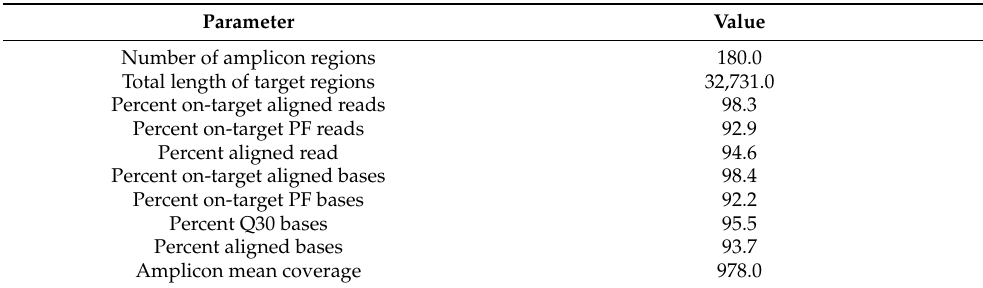
Table 1. Sequencing Parameters. General sequencing metrics as obtained with 48 pooled samples on a single iSeq-100 run.